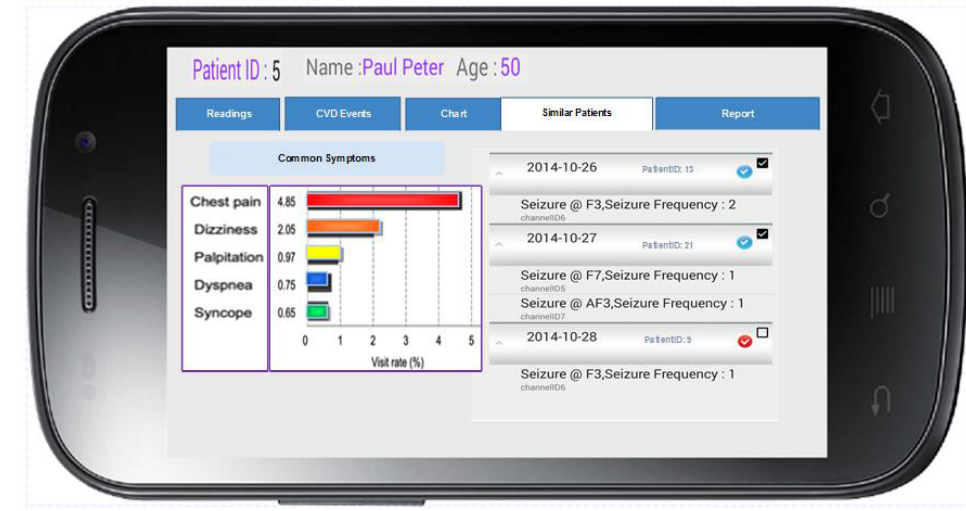
Figure 3. Visualization dashboard—A physician’s